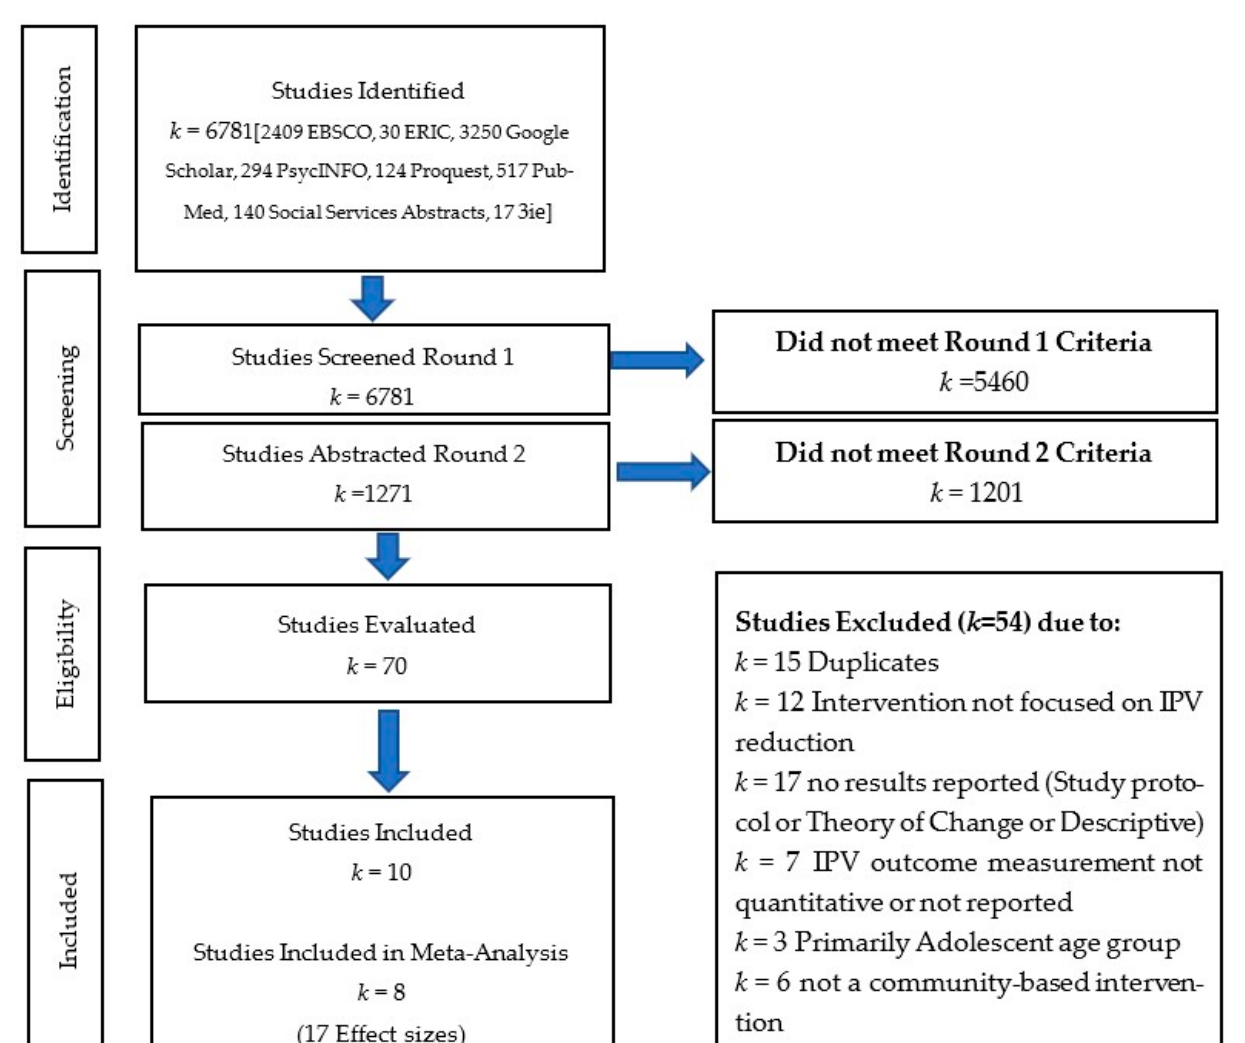
Figure 1. PRISMA flowchart of included studies.